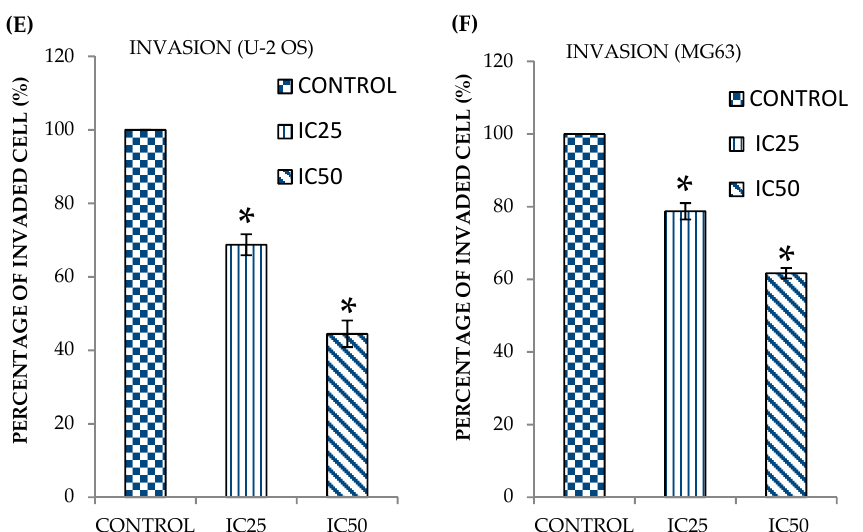
Figure 2. Representative images of transwell migration/ invasion assays for both ( A ) U-2 OS and ( B ) MG-63 after being treated with two different concentrations (IC 25 , IC 50 ) of DK1 for 48 h. For migration assay the cells were required to migrate through membrane with 8 µM pore-size. While for invasion assay the cells were allowed to invade the same pore-size membrane coated with matrigel. ( C , D ) Quantification analysis of U-2 OS and MG-63 based on the percentages of migrated cell treated with DK1. ( E , F ) Percentages of invaded cell for both U-2 OS and MG-63 treated with DK1. All experiments were done in triplicate and all data were expressed as mean ± standard error mean (S.E.M). * p < 0.05 compared with corresponding control. (Magnification: 100×).